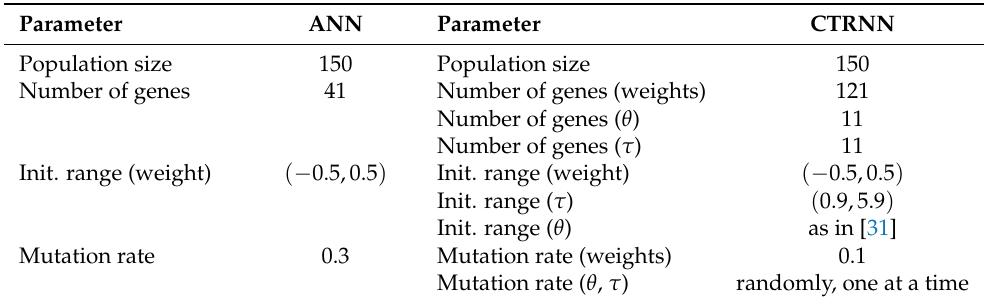
Table 1. Parameters used for the evolutionary algorithm. CTRNN, Continuous-Time Recurrent Neural